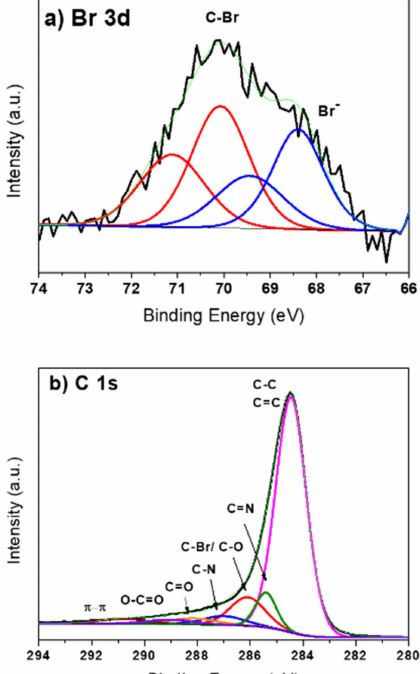
Figure 2. High-resolution X-ray photoelectron spectroscopy (XPS) spectra of Br 3d ( a ) and C 1s ( b